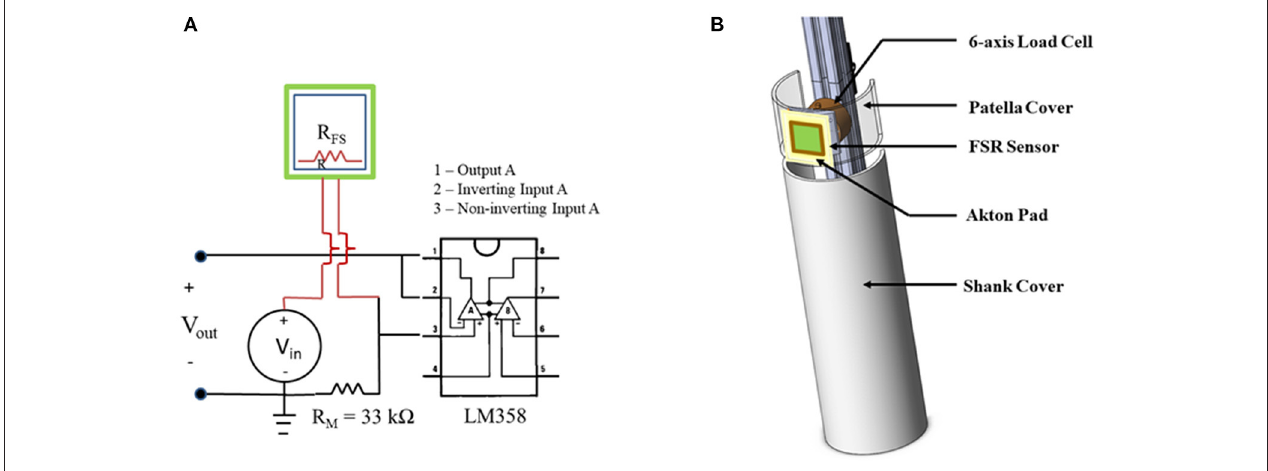
FIGURE 1 | Validation set up. (A) Diagram of force sensitive resistors (FSR) sensor electrical circuit with amplification. (B) 3D sketch of design of instrumented lower leg (ILL) used for FSR validation testing.